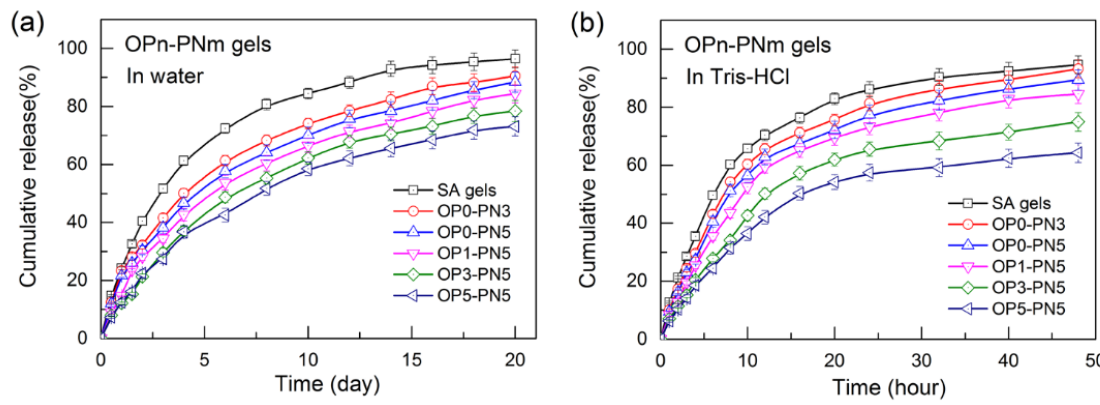
Figure 10. Release profiles of bovine serum albumin (BSA) in OPn-PNm gels in different solutions: ( a ) deionized water; ( b ) Tris-HCl buffer solution, 25 mM, pH = 7.3.